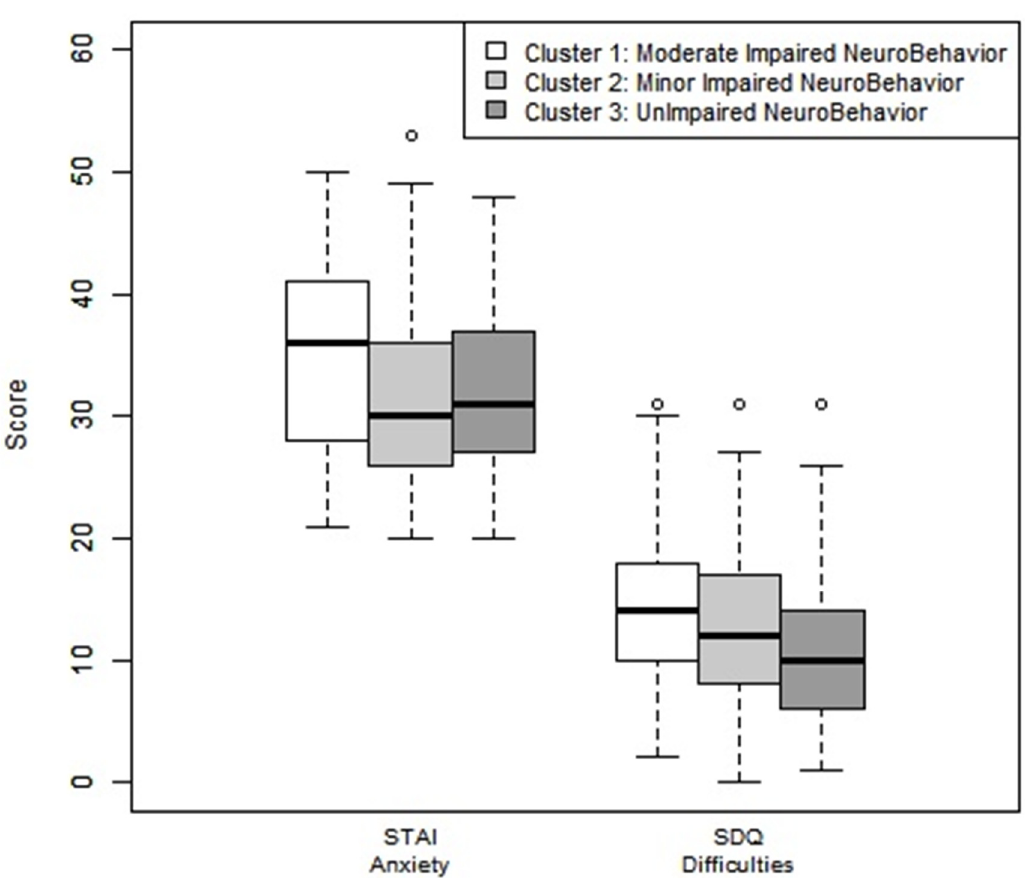
Figure 4. Anxiety assessment by STAI questionnaire and behavior assessments by Goodman-SDQ test by clusters. Note: Goodman-SDQ (Strengths and Difficulties Questionnaire): Scores were correlated with Achenbach’s Child Behavior Checklist (CBCL), including 25 items targeted for the parents. The questionnaire reflected a total assessment score of the